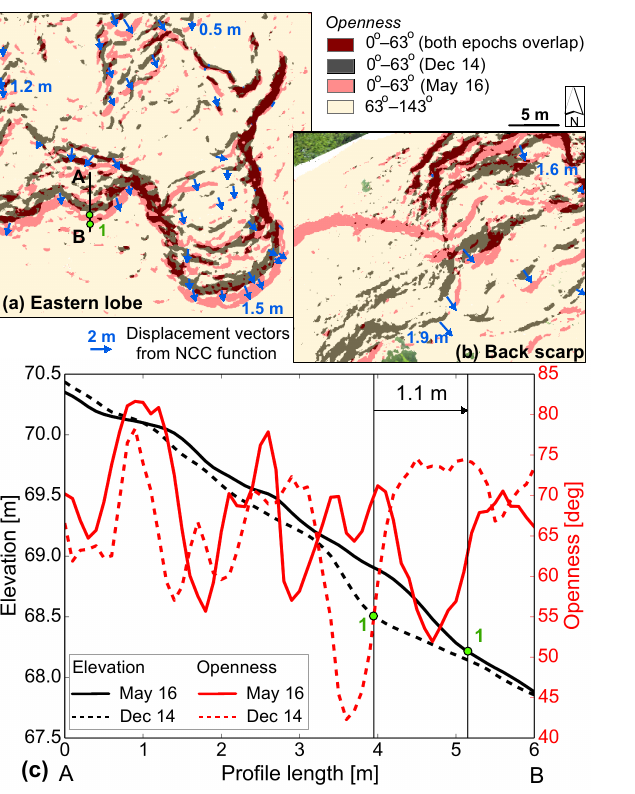
Figure 4. Detailed view of December 2014 and May 2016 openness maps over the (a) eastern lobe and (b) back scarp with elevation and openness plotted along (c) profile AB (Peppa et al.,